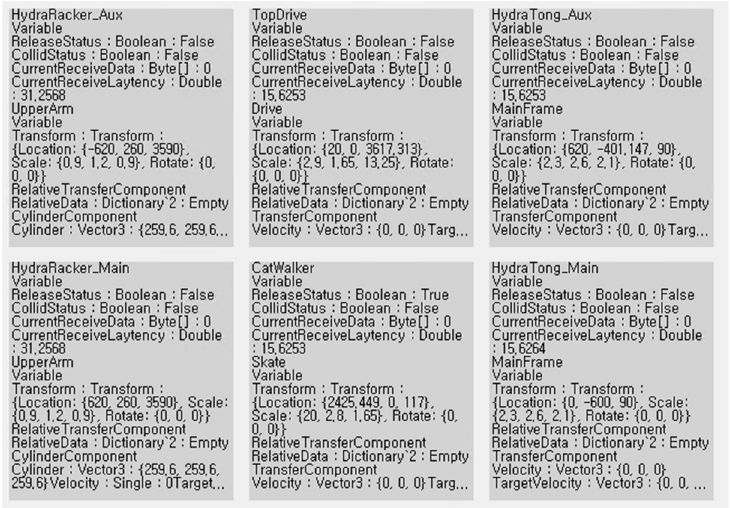
Figure 5. Example of visualized parameters containing motion and system information of each ma- Figure chine.